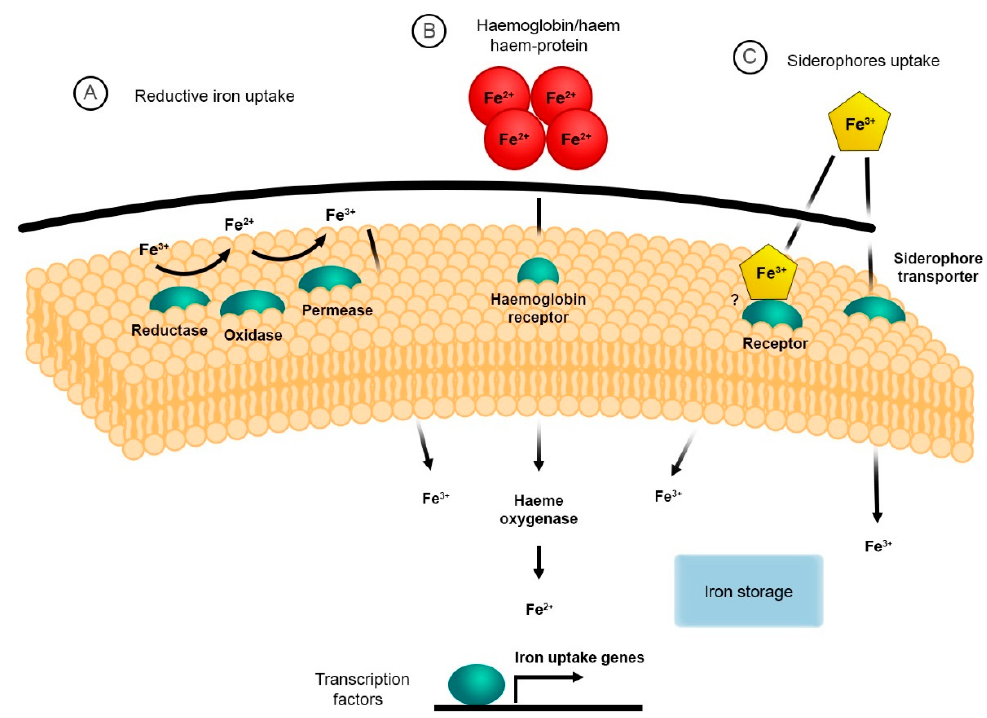
Figure 1. General strategies for iron acquisition in pathogenic fungi. ( A ) the reductive system responsible for iron assimilation via reduction and oxidation followed by transport into the cytoplasm via specialised iron permeases; ( B ) haem -iron uptake and degradation, which facilitates iron chelation from haemoglobin and haem -proteins; ( C ) siderophore uptake system that allows for iron acquisition from a spectrum of siderophores and xenosiderophores (figure adapted from [40]).